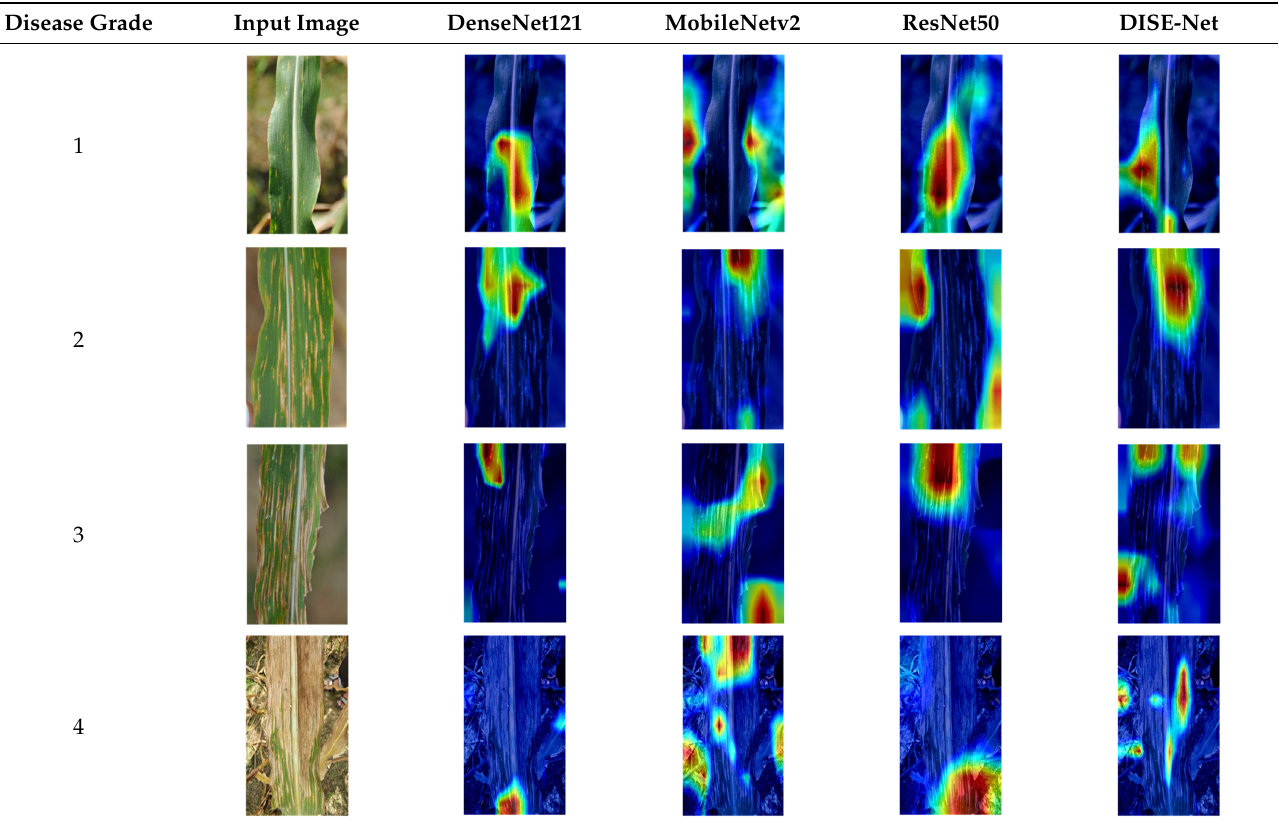
Table 9. Attention heat maps of DenseNet121, MobileNetv2, ResNet50 and DISe-Net for identifying maize minor spot disease with different grades.